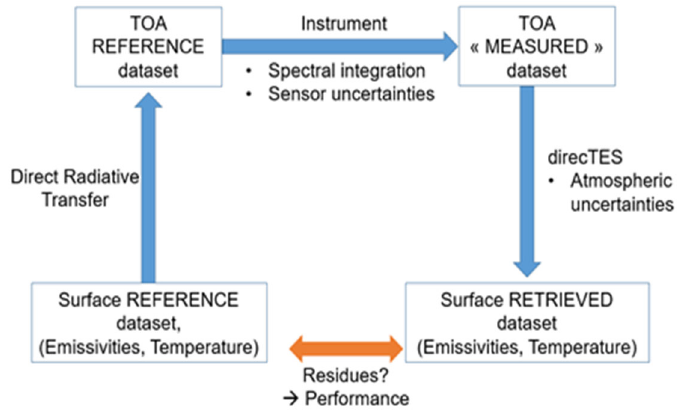
Figure 7. Principle of end-to-end simulations to establish the theoretical performance of DirecTES.